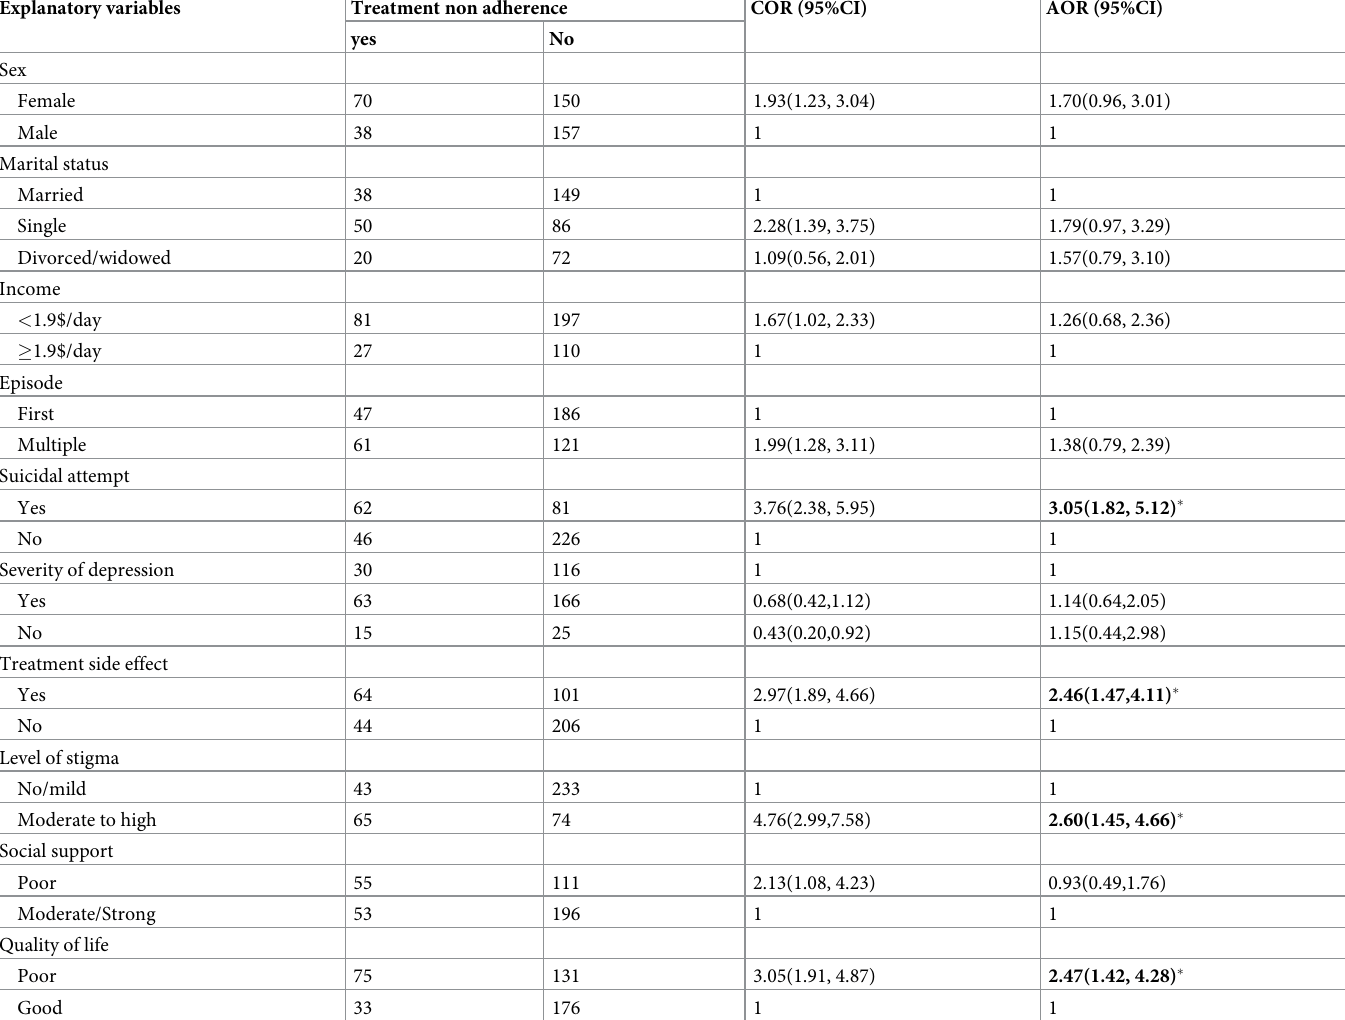
Table 3. Bivariable and multivariable binary logistic regression analysis showing association between treatment non adherence and related factors among study